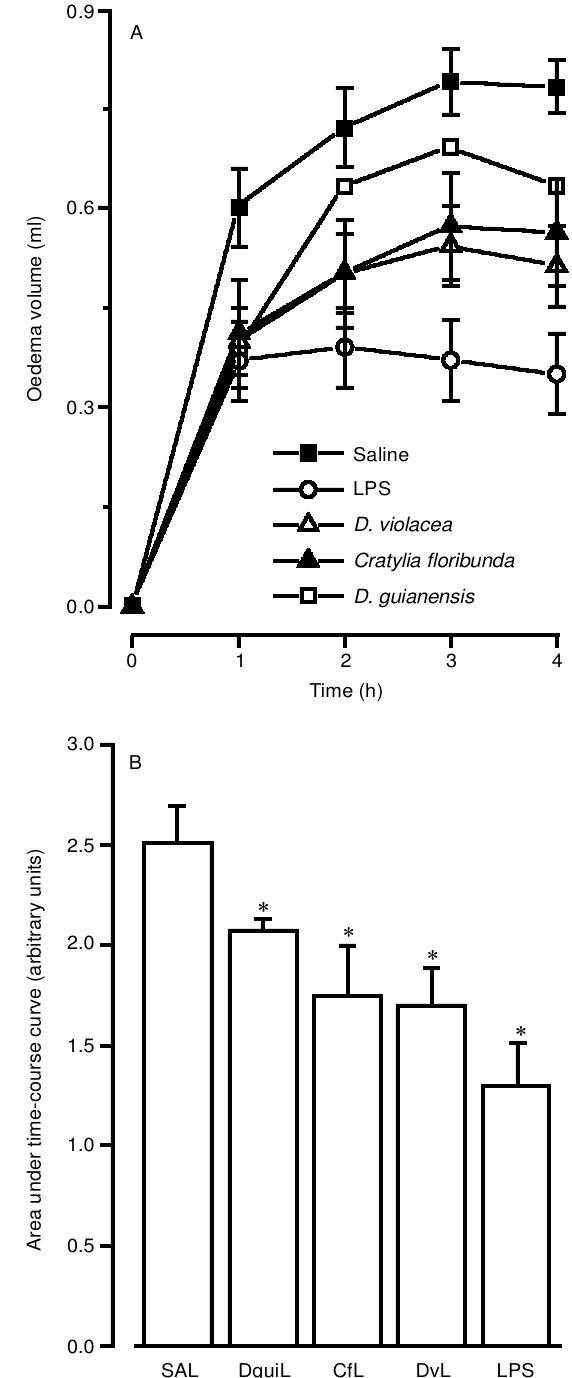
FIG. 5. Inhibition by lectins from D. violacea (DvL), Cratylia ¯ oribunda (CfL) and D. guianensis (DguiL) of rat paw oedema induced by intraplantar injection of carrageenan (300 m g / 0 · 1 ml). The animals were treated (0 · 1 ml / 100 g, i.v.) 30 min before Cg injection, with saline (SAL), LPS (30 m g / kg) or lectins (1 mg / kg). Control animals received Cg both by intraplantar and i.v. routes. (A) Oedema was meas- ured at 1, 2, 3 and 4 h after the in¯ ammatory challenge and expressed as the increase in paw volume (ml) above its basal volume. (B) The area under the time-course curve was determined using a trapezoidal rule. Each point repre- sents the mean SEM from six rats. Indicates a signi® - cant statistical difference ( P , 0.05), compared to the SAL group (ANOVA, Duncan’s